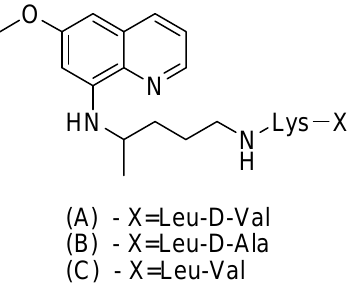
Figure 22. Chemical structures of (A) D -valylleucyllysylprimaquine, (B) D -alanylleucyl- lysylprimaquine and (C) valylleucyllysylprimaquine.